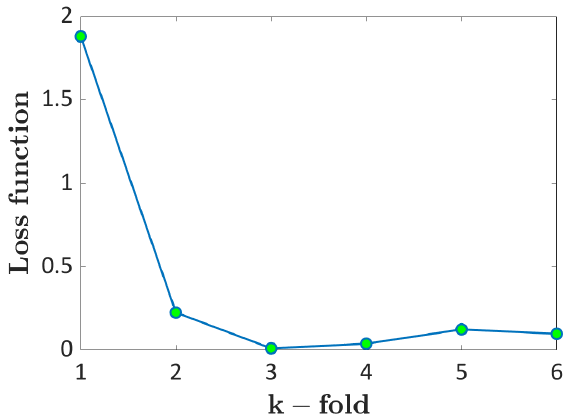
Figure 13. k-fold cross validation of the Probability ML algorithm: loss function with respect to the fold considered for the validation.